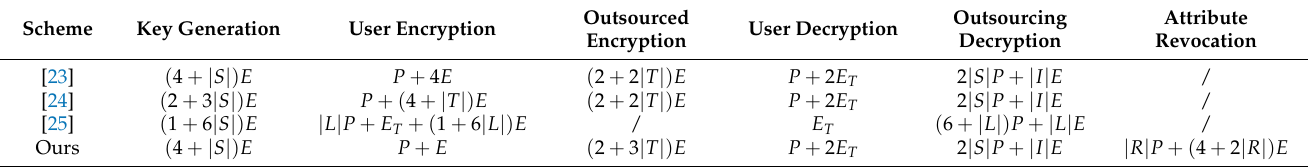
Table 3. Comparison of computational cost.